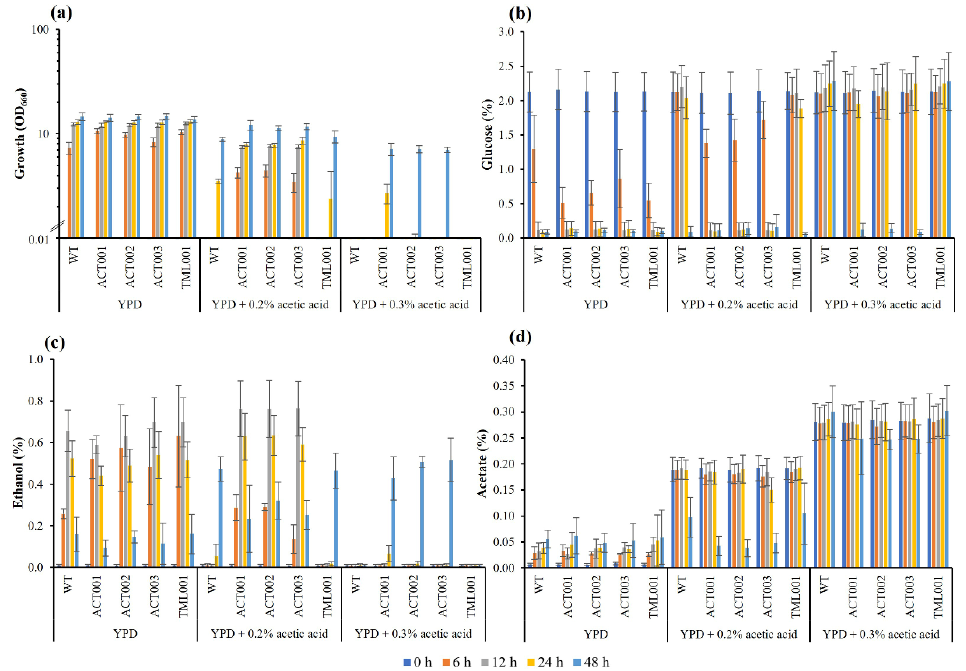
Figure 4. Effects of acetic acid on growth and fermentation parameters of adapted strains at 40 °C. Adapted strains were cultivated in YPD medium supplemented with 0.2% or 0.3% acetic acid at 40 °C under a shaking condition at 160 rpm for 48 h. Growth ( a ) was determined by measuring OD 660 . Glucose ( b ), ethanol ( c ), and acetate ( d ) were determined by HPLC. Error bars represent ±SD of values from experiments performed in triplicate.